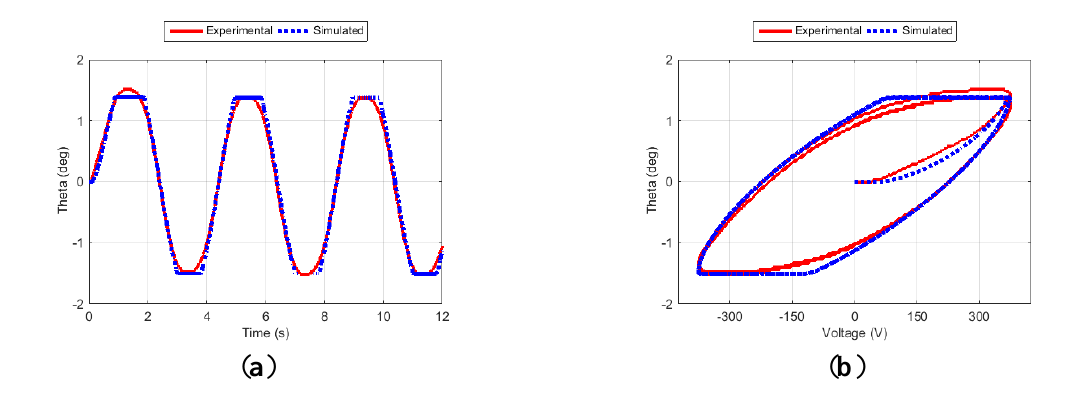
Figure 6. Fin angle ( a ) and hysteresis curve ( b ) for Case 1.